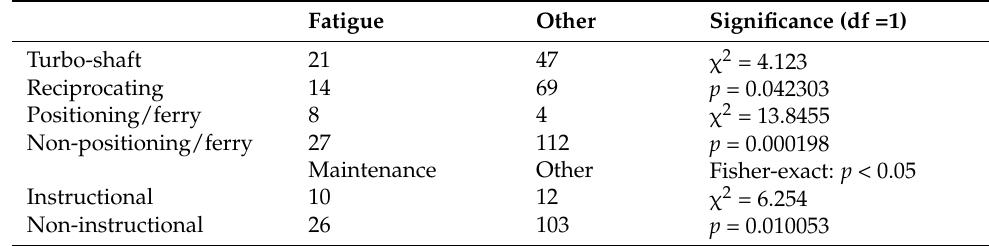
Table 3. Significant relations between specific operations/aircraft and types of